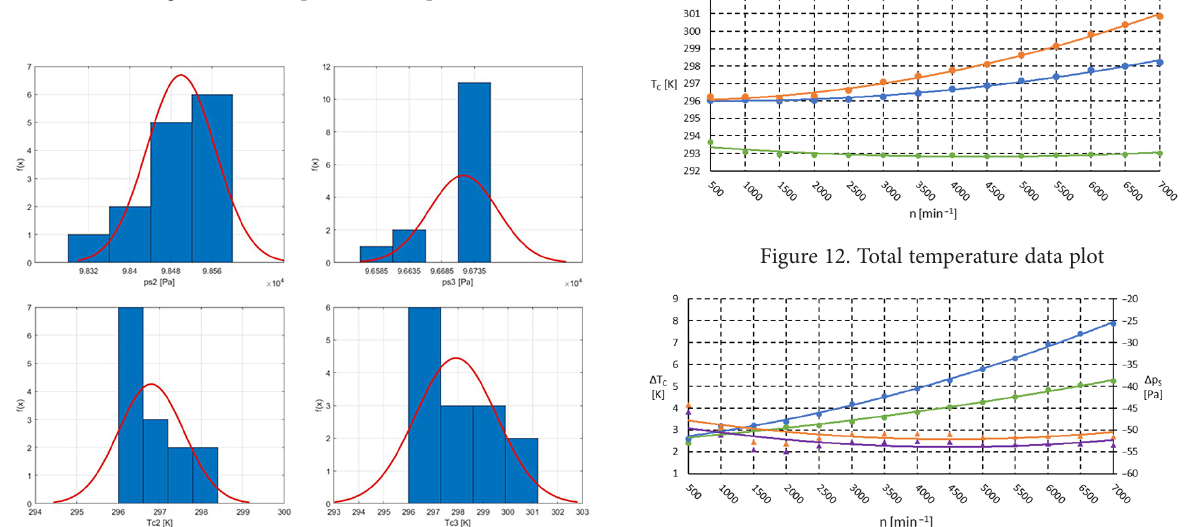
Figure 10. Static pressure data plot